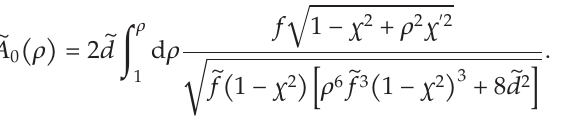
Figure 8: Examples for the background gauge field time component potential (cid:11) μ (cid:2) b (cid:3) . Note that the chemical potential is not zero at asymptotically small but nonzero m > 1 . 3, reproducing the phase transition line in Figure